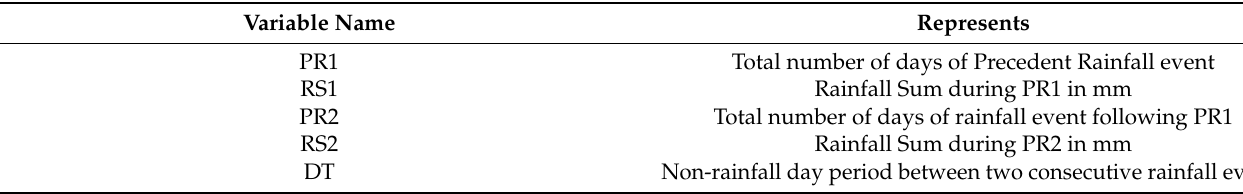
Table 2. Variables created to track rainfall days, dry days, and rainfall amounts leading to a landslide event in the